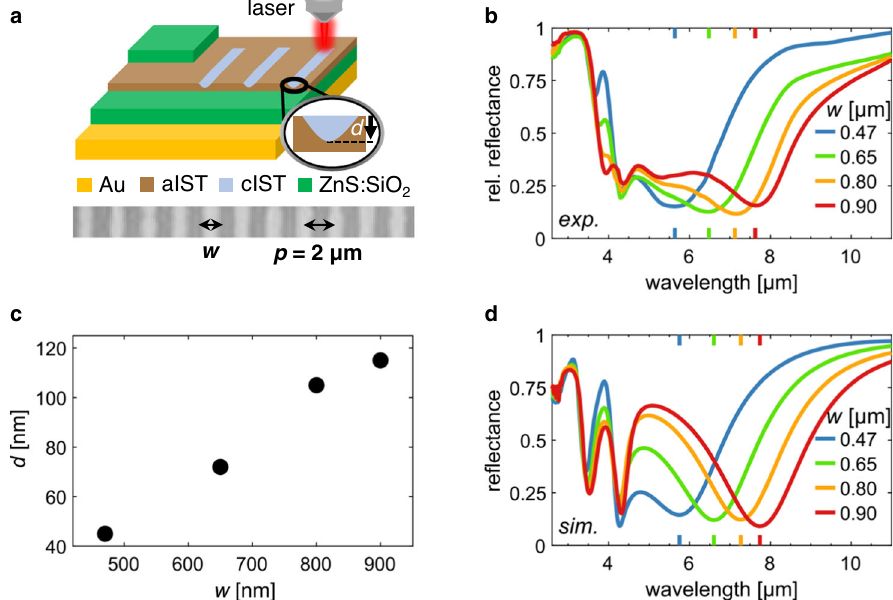
Fig. 4 Optical writing of frequency-selective IR absorber. a Top: Sketch of the absorber layer stack and grating pattern structure. cIST bars of variable width w and period p can be written into the surface with the pulsed laser. The inset sketches the crystallization depth d . Bottom: Light microscope image excerpt of a cIST absorber, denoting the fi xed period p = 2 µ m and the bar width w . b Measured re fl ectance spectra of the IR absorbers with p = 2 µ m con fi gured to absorb at different spectral ranges by changing the bar width w from 0.47 to 0.9 µ m. The magnetic resonance positions are marked with colored ticks. c Crystallization depth d of the simulated cIST bars vs. their width w . d Simulated re fl ectance spectra corresponding to b